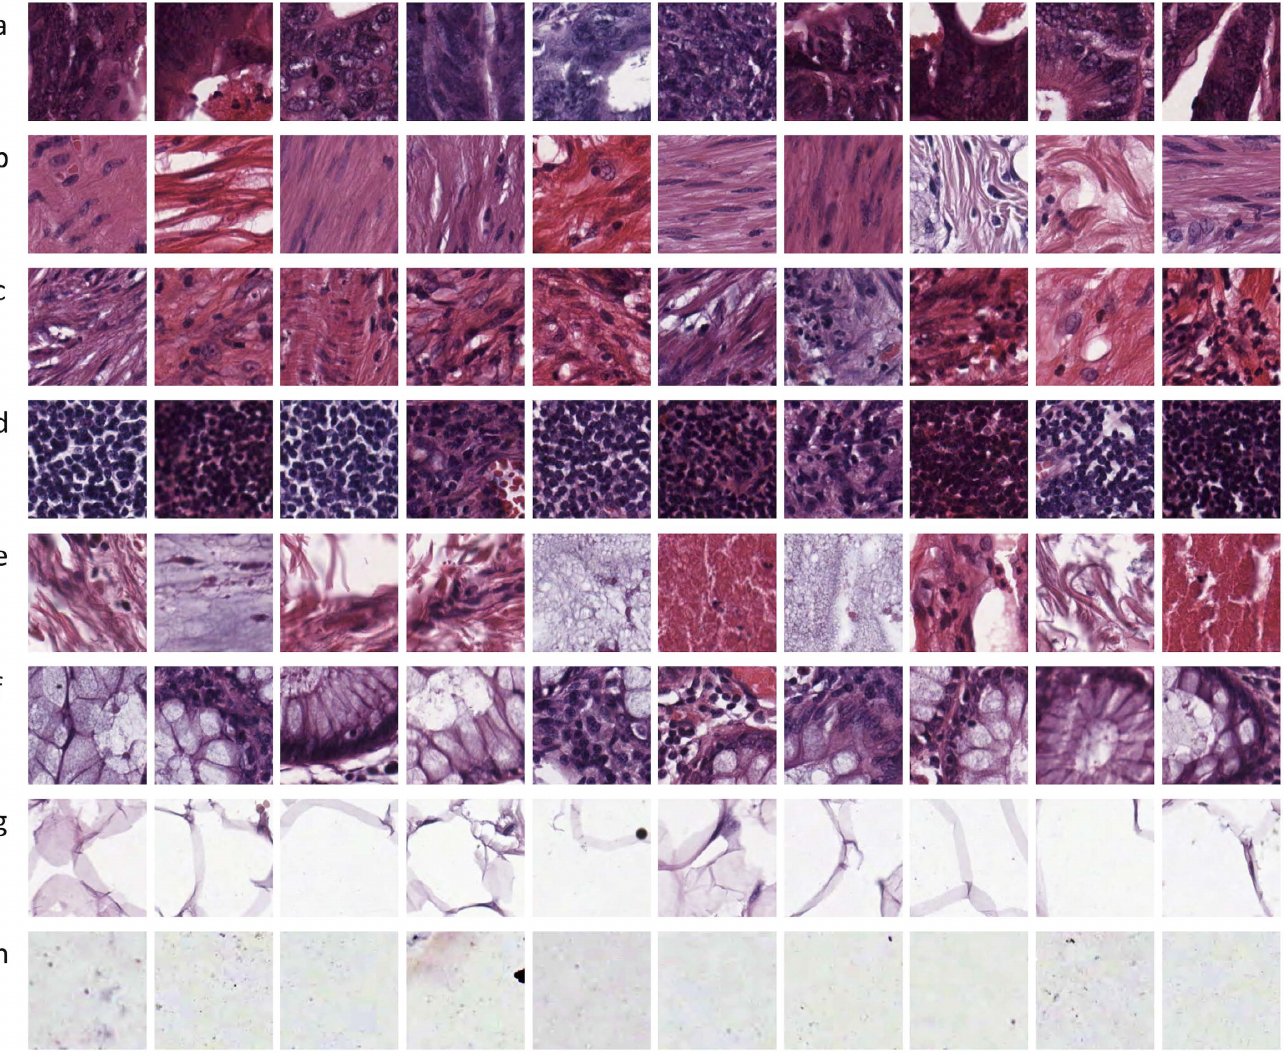
Figure 10. Example of colorectal cancer histology. ( a ) Tumor epithelium, ( b ) simple stroma, ( c ) com- plex stroma, ( d ) immune cell conglomerates, ( e ) debris and mucus, ( f ) mucosal glands, ( g ) adipose tissue, ( h )